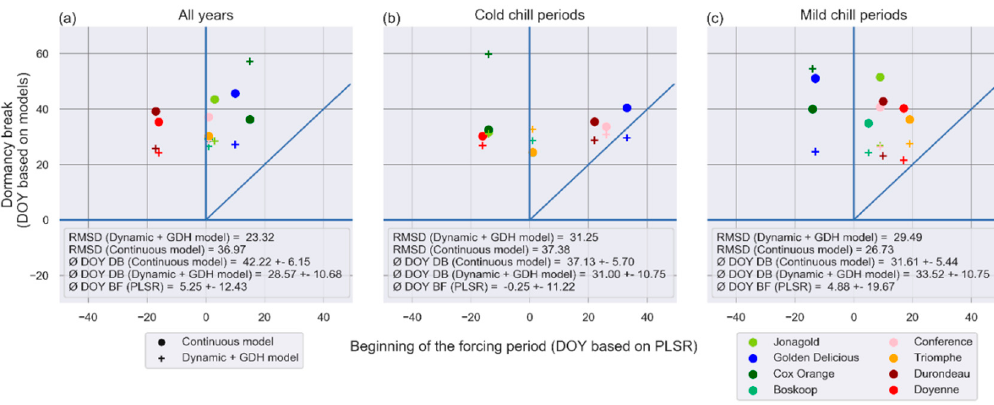
Figure 6. Day of the year (DOY) of the cultivar specific dormancy break (DB) simulated by the continuous model and the dynamic + growing degree hour (GDH) model, against the beginning of the forcing period (BF) estimated using the PLSR method, for all years ( a ), the 50% cold ( b ) and 50% mild years ( c ), as defined by the average temperature during October, November, and December. Symbols distinguish between used models. The diagonal lines represent the identity line, X = Y, horizontal and vertical lines highlight DOY = 0 as reference. The root mean square difference (RMSD) value corresponds to the average RMSD between the model output and the PLS results. Ø DOY gives the average specified DOY for the given years with one standard deviation.